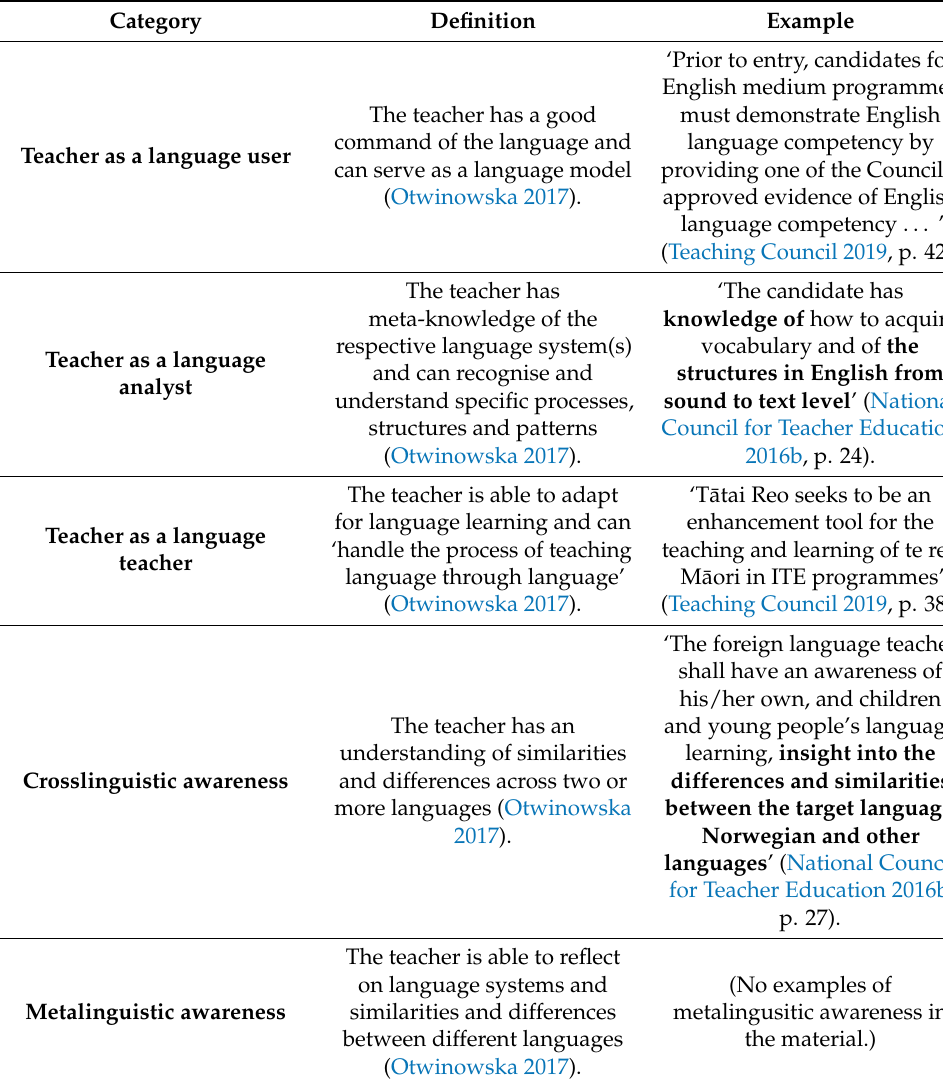
Table 1. Categories for TLA (adapted from Otwinowska